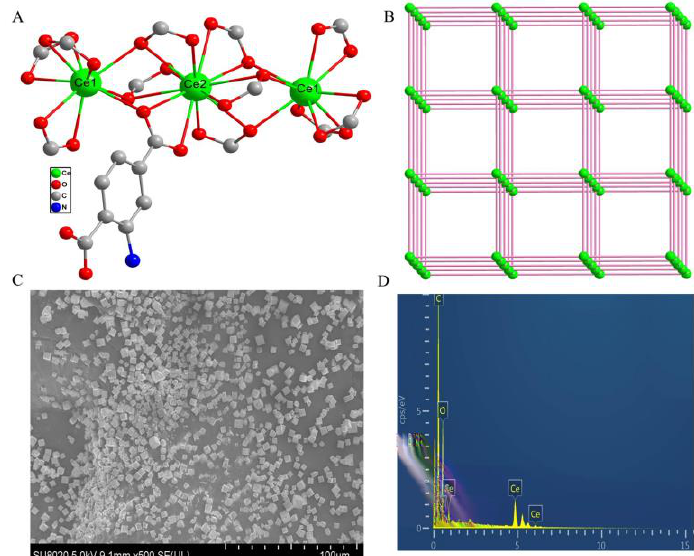
Figure 3. Characterization of the Ce-based MOF for the assembly of aptamer for ATP determination. ( A ) Coordination environments of Ce 3+ ions and 2-aminoterephtalic acid; ( B ) the 3-D topological structure; ( C ) SEM image; ( D ) EDX elemental mapping [88].